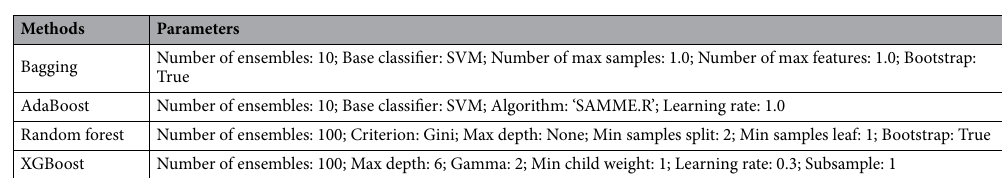
Table 2. The parameter setting of the ensemble learning